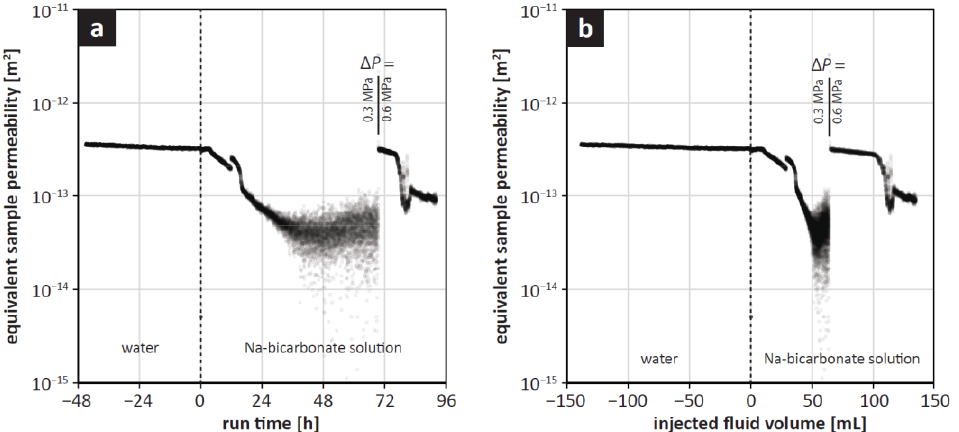
Figure 3. Equivalent Darcy permeability of sample BC-1 versus ( a ) elapsed time and ( b ) injected fluid volume. Run time and volume are shifted such that they equal zero at the moment when injection of sodium bicarbonate solution was started (water-based reference results are thus plotted on negative domains of the x-axes).